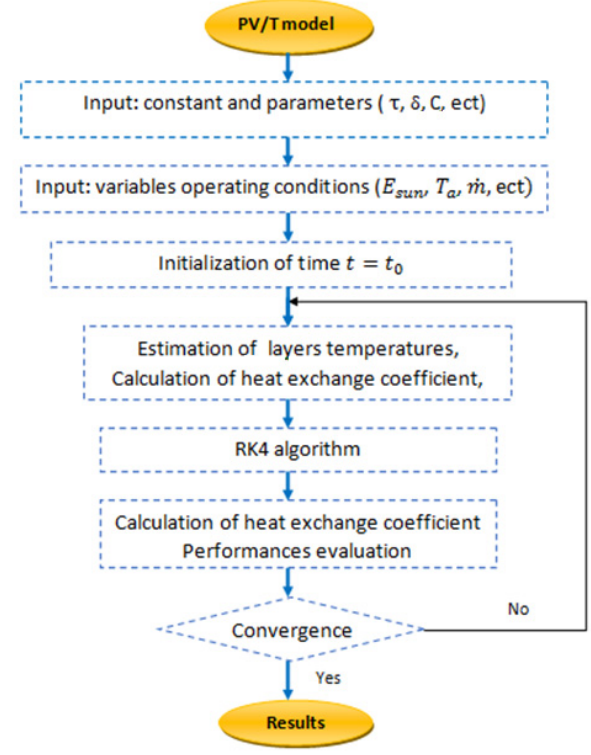
Figure 2. Flow chart of the PV/T numerical modeling.